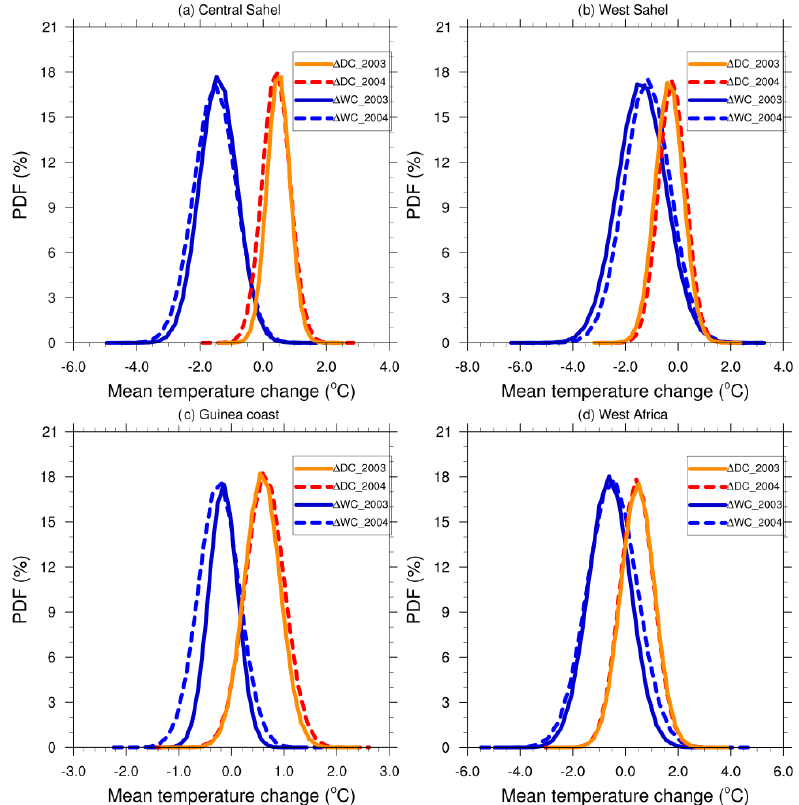
Figure 13. PDF distributions (%) of mean temperature changes in JJAS 2003 and JJAS 2004 over the (a) Central Sahel, (b) West Sahel, (c) Guinea and (d) West Africa derived from dry ( (cid:49) DC) and wet ( (cid:49) WC) experiments compared to the control experiment.